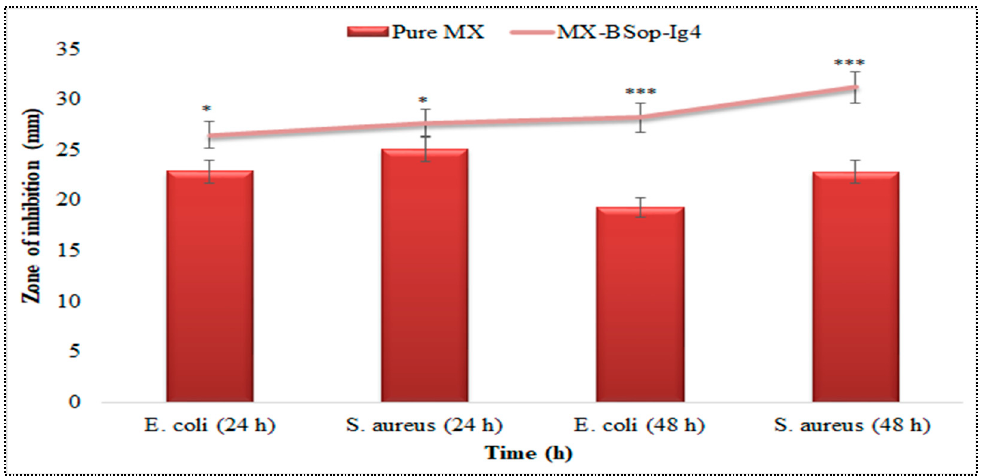
Figure 12. Antibacterial activity of MX-BSop-Ig4 and pure MX solution treated against E. coli and S. aureus. The study was performed in triplicate, and data are shown as mean ± SD. * indicates signif- icant and *** indicates highly significant to pure